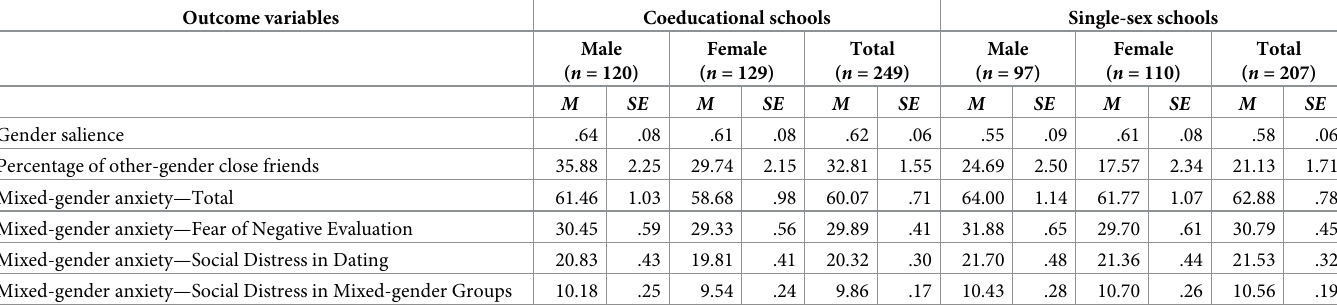
Table 8. Estimated marginal means and standard errors of the outcome variables (Study 2: College